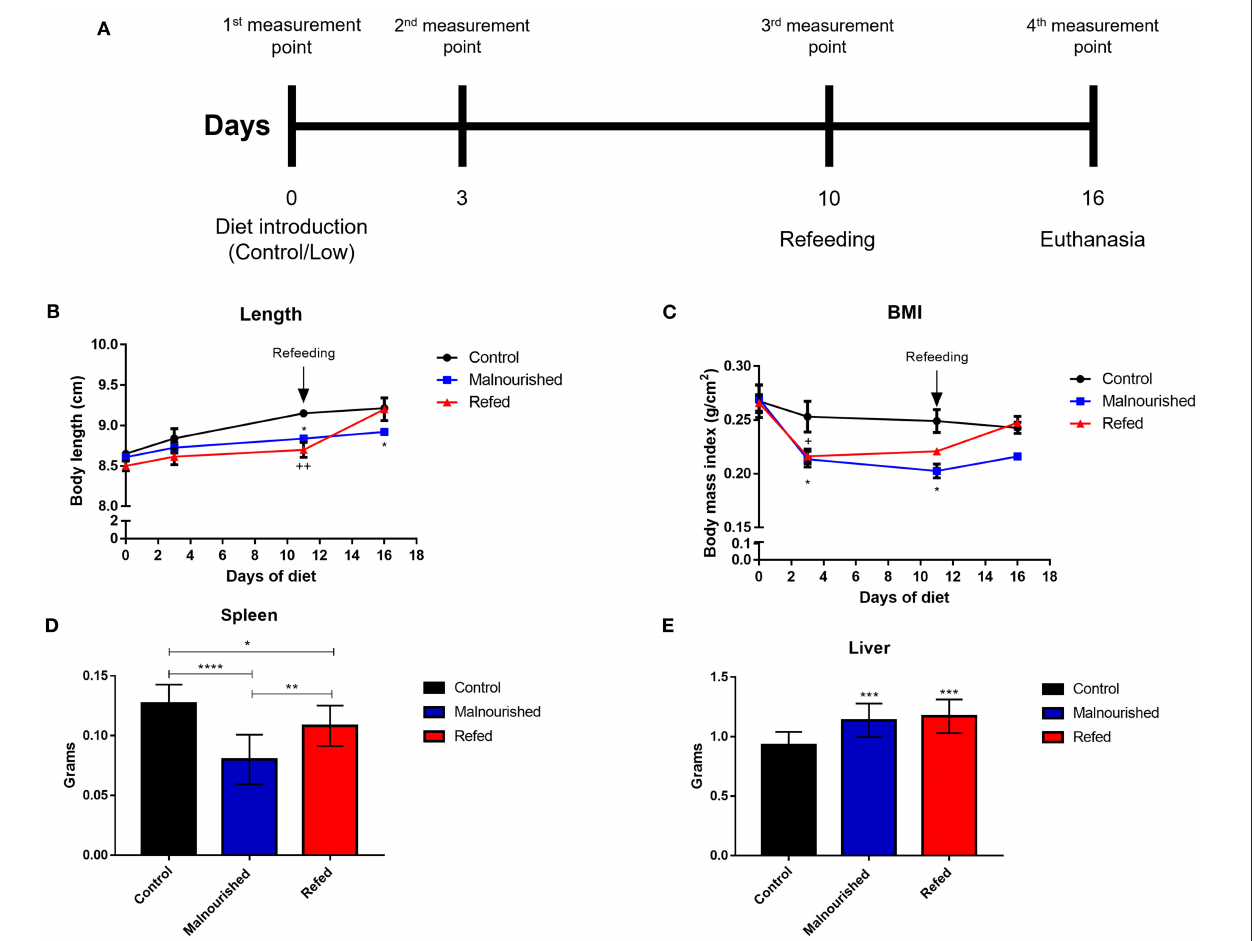
FIGURE 3 | Evaluation of phenotypic markers of mice submitted or not to experimental malnutrition and refeeding. Mice were provided different diets, and body measurements were calculated at days 0, 3, 10, and 16 after diet introduction (A) . (B) Body length. (C) Body mass index. Mice were euthanized (day 16) and total weight of spleen (D) and liver (E) were weighed on a digital scale. Black: control mice; blue: malnourished mice; red: refed mice. * p ≤ 0.05; ** p ≤ 0.005; *** p ≤ 0.0005; **** p < 0.0001; + p ≤ 0.05; ++ p ≤ 0.005; (*) Malnourished vs. control; ( + ) refed vs. control. The values are represented by the mean ± standard error of three independent experiments with 15 animals in each